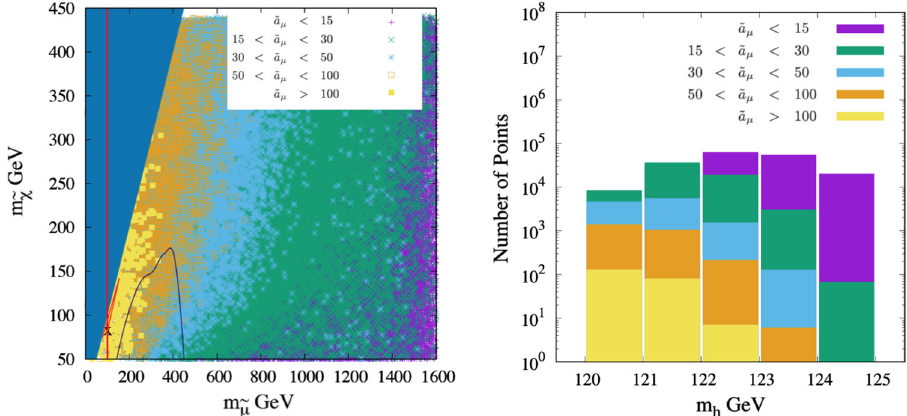
, m χ ) ton mass [118]. Also visible at small masses are the LHC constraints R on ˜ (cid:7) R → (cid:7)χ where (cid:7) = e ,μ [119]. The point with the largest value of (cid:3) a μ = 150 × 10 − 11 is indicated with a cross. Right panel: Stacked histograms of the numbers of points with ˜ a μ and m h in the indicated